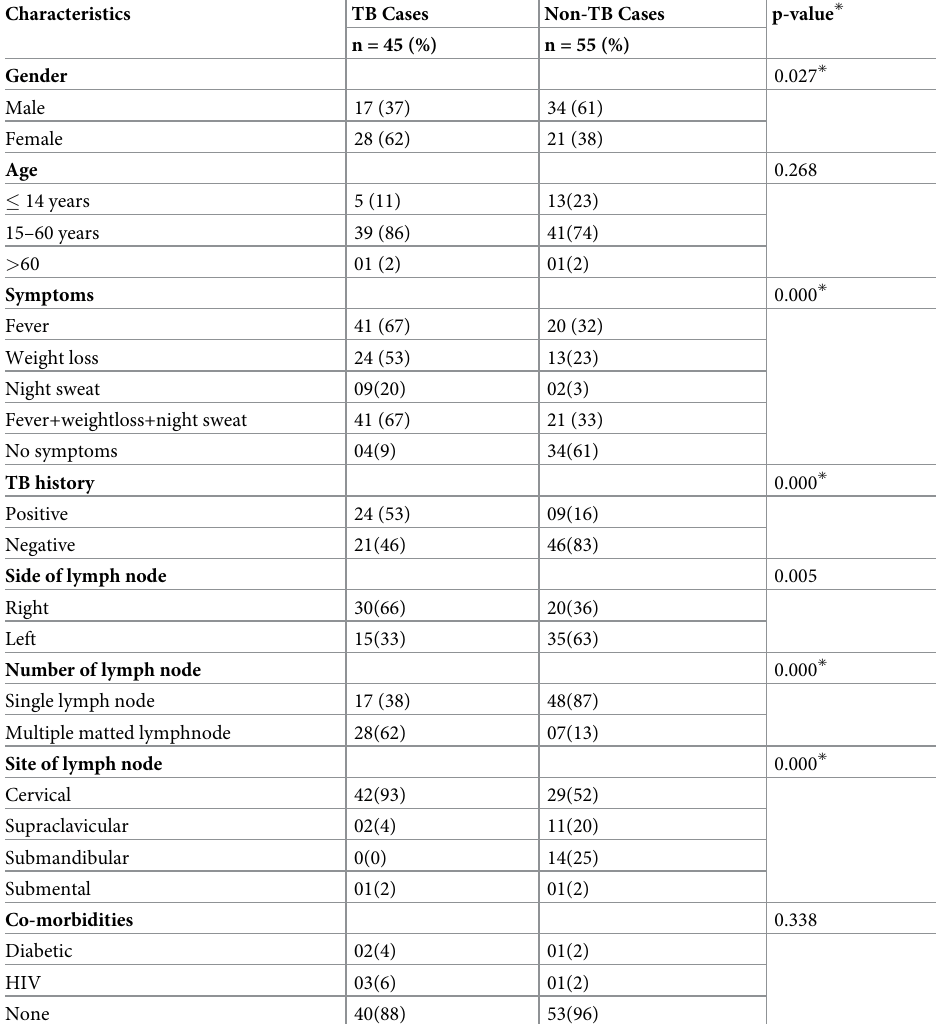
Table 1. Demographic and clinical characteristics of patients.